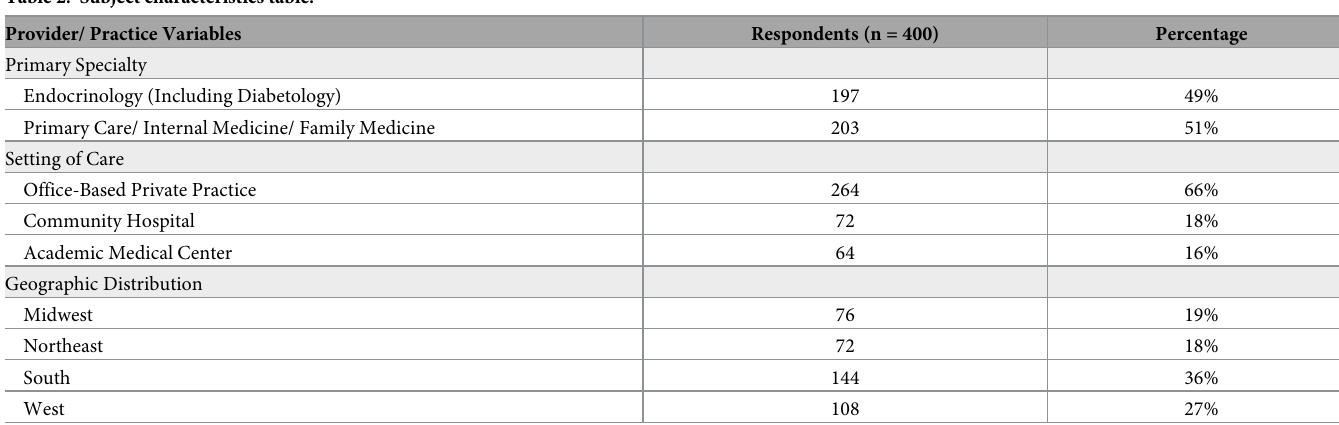
Table 2. Subject characteristics table.